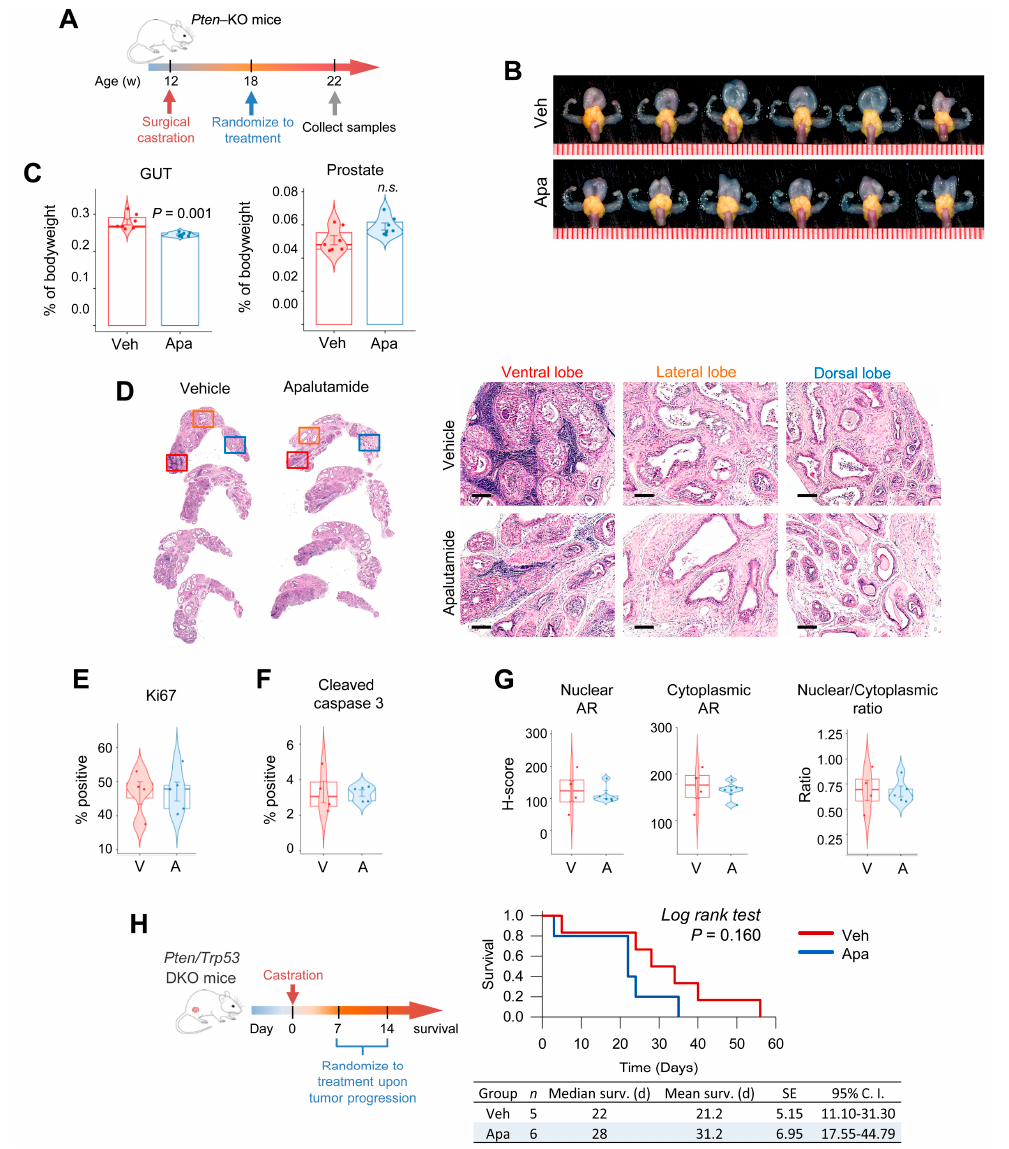
Figure 3. Antitumor activity of apalutamide in mouse Pten -deficient castration-resistant prostate cancer (CRPC). ( A ) Apalutamide (Apa, 30 mg/kg, p.o. 5 times/week) or the vehicle (Veh) were administered to PSA Cre ; Pten loxP/loxP (KO) mice ( n = 6 mice/group) evaluated in an early-stage model of CRPC. ( B ) Representative images of the genitourinary tracts (GUTs) collected en bloc; prostate tumors are highlighted in yellow. Scale represents mm. ( C ) The effect of apalutamide on normal secondary sex organs and prostate tumors was evaluated by comparing the genitourinary tract (GUT) weights, and antitumor activity was assessed by comparing the weights of the dissected prostates. Horizontal bars represent the mean ± SE, center lines show the medians and box limits indicate the 25th and 75th percentiles, and the violin plots show the distribution. ( D ) Representative H&E-stained sections of KO mouse prostate tumors are shown as low magnification scans with corresponding high magnification photomicrographs. Scale bars = 250 μ m. Immunohistochemical (IHC) quantification of cancer cell proliferation ( E ), apoptotic rates ( F ) and AR expression ( G ) in KO mice treated with the vehicle (V) or apalutamide (A). Horizontal bars represent the mean ± SE, center lines show the medians and box limits indicate the 25th and 75th percentiles, and the violin plots show the distribution with the circles representing individual samples. ( H ) The therapeutic benefit of apalutamide was assessed in a late-stage model of advanced CRPC using PSA Cre ; Pten loxP/loxP /Trp53 loxP/loxP (DKO), as illustrated, and the Kaplan–Meier plots compare the overall survival curves for mice according to treatment. Unless indicated, p values indicate significance of the Student t